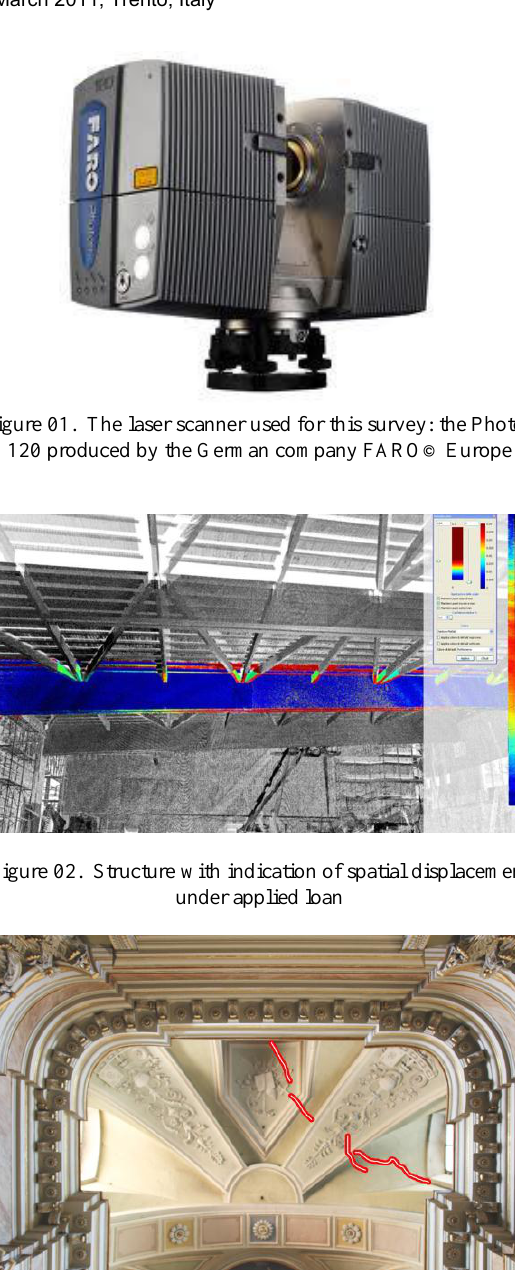
Figure 03. Crack representation on the vault